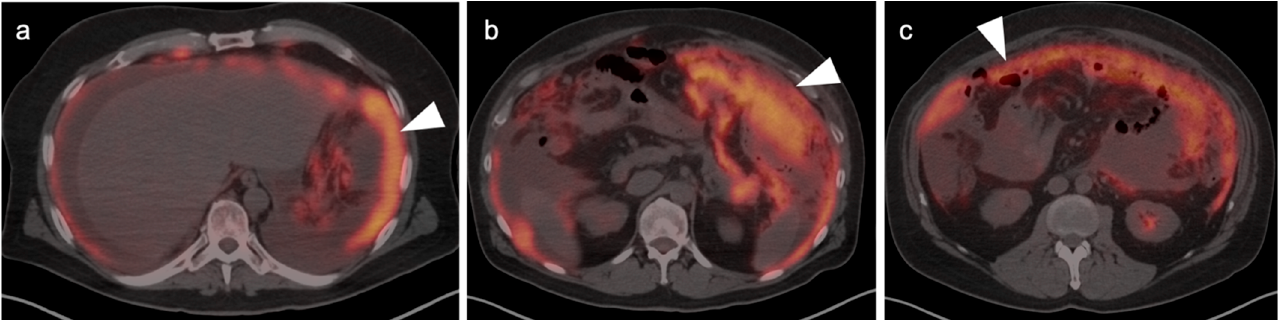
Figure 28. IgGS4-associated autoimmune pancreatitis in a 72-year-old with biliary obstruction and abdominal pain. Axial fused FDG PET-CT images of the head ( a ) and body/tail ( b ) of the pancreas (white arrowheads) show that the pancreas is diffusely hypermetabolic, somewhat featureless, sausage-shaped and larger than normal for an older person.